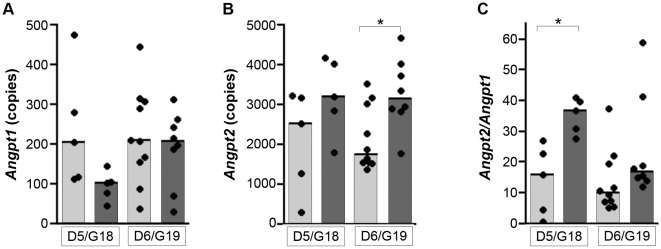
Placental Angpt2 mRNA expression is increased by malaria infection (P = 0.0063, 2-way ANOVA).
(A) Angpt1 and (B) Angpt2 transcripts were measured by real-time quantitative PCR using cDNA templates reverse transcribed from placental RNA from pregnant mice uninfected (light bars) and infected with P. berghei (dark bars). Copy number was normalized to housekeeping gene expression as described in Materials and Methods. (C) The relative expression of Angpt2/Angpt1 is also increased in placentas associated with viable fetuses of infected mice (P = 0.0032, 2-way ANOVA on log-transformed data). Dots are individual placentas associated with viable fetuses; bars represent the median of each group. 4–6 mice are represented per group. *P<0.01 (Bonferonni post-test). D, day post infection/control injection; G, gestational day.